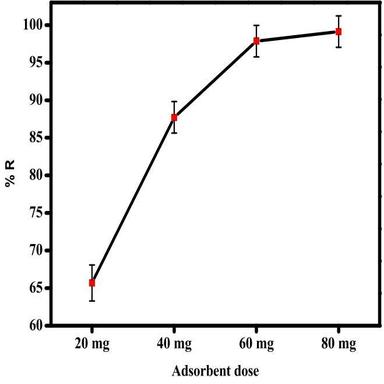
Effect of pH on modified cellulose. Fig. 7. Effect of adsorbent dose of modified cellulose.